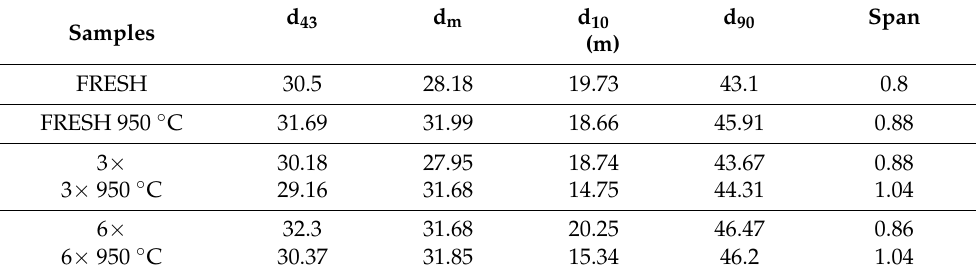
Table 2. Particle size results evaluated using laser diffraction